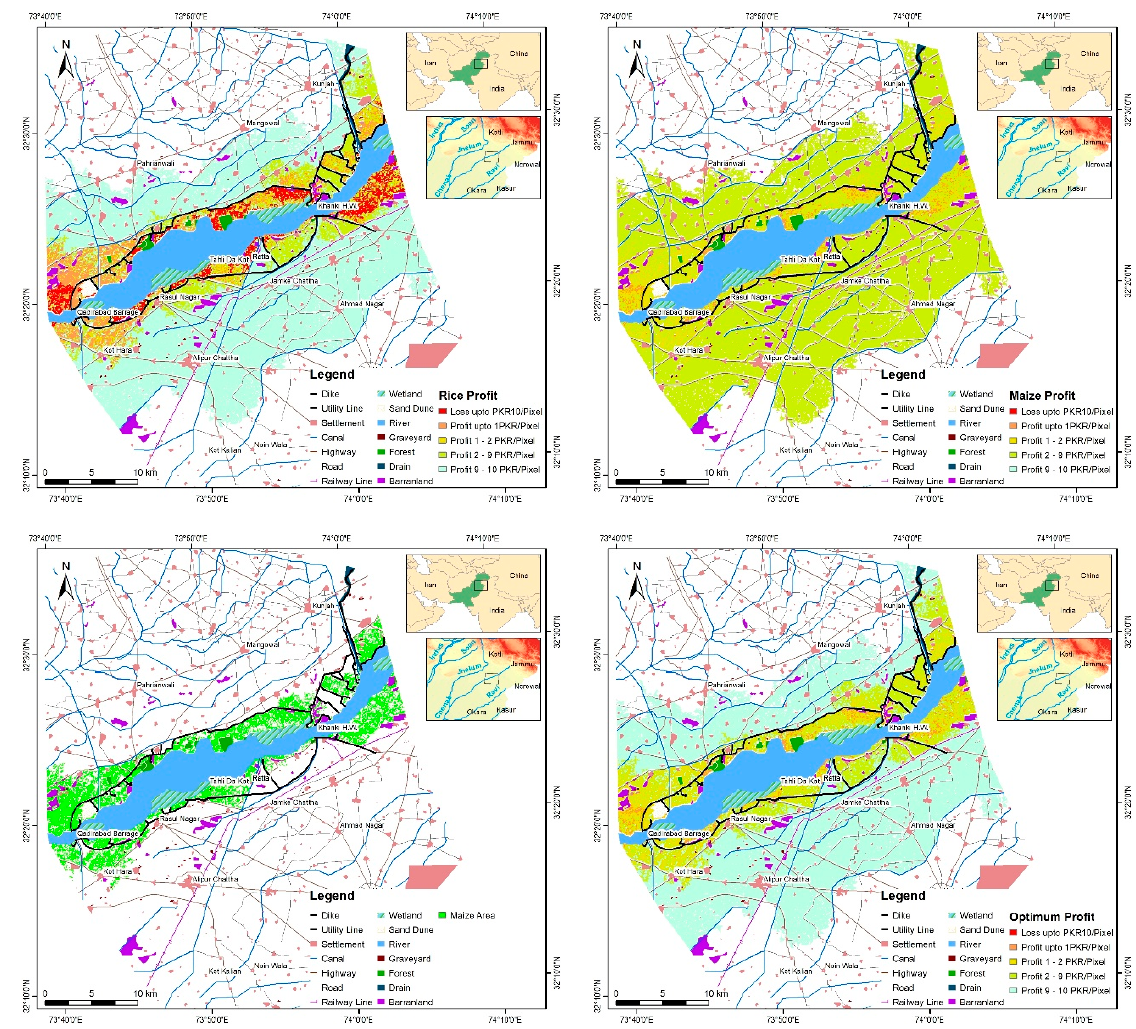
Figure 11. Top left map shows the spatial distribution of profit for rice crops in the floodplain. The top right map shows the profit for maize. The bottom left map shows the area where maize is more profitable compared to rice in the floodplain. The bottom right shows the ideal combination of maize and rice in the floodplain.